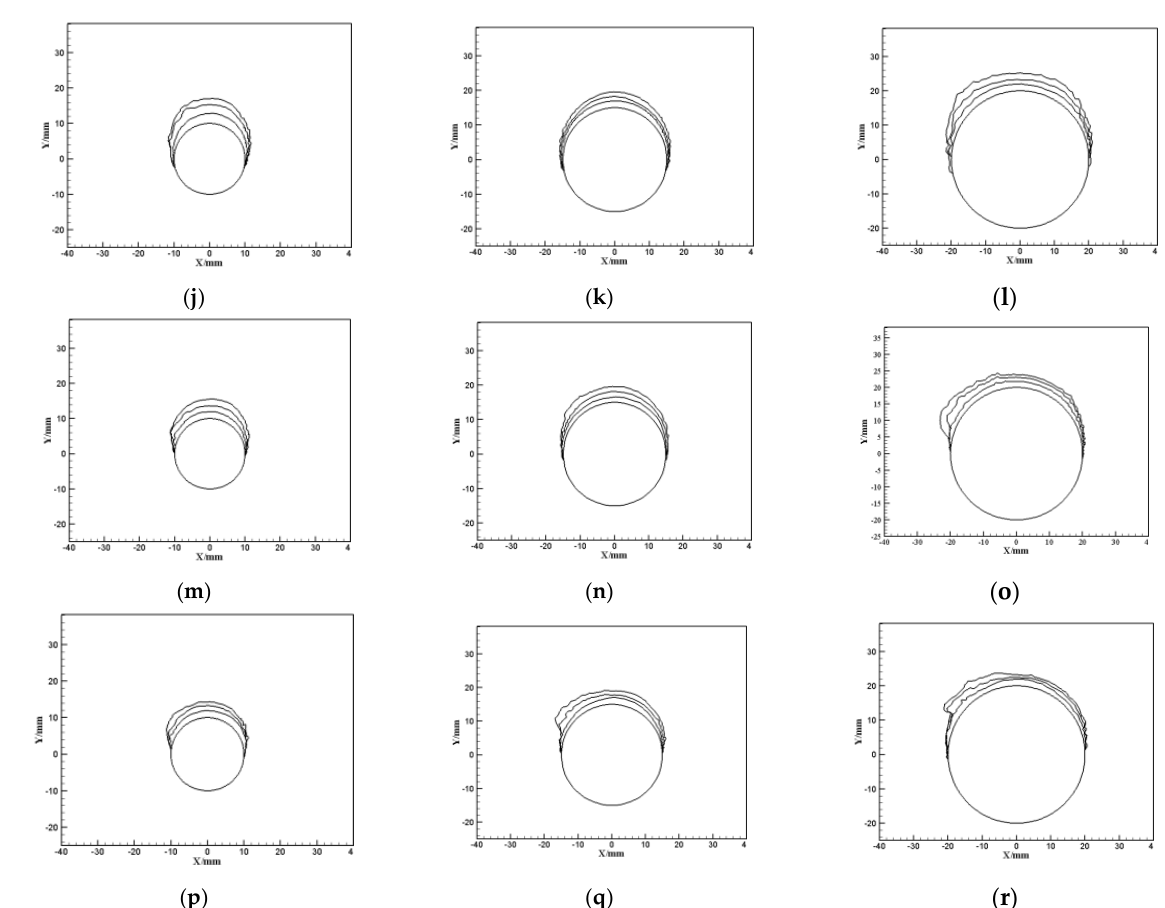
Figure 6. Test results of icing on the rotating cylinder surface under different TSRs: ( a ) λ = 0.2, d = 20 mm; ( b ) λ = 0.2, d = 30 mm; ( c ) λ = 0.2, d = 40 mm; ( d ) λ = 0.6, d = 20 mm; ( e ) λ = 0.6, d = 30 mm; ( f ) λ = 0.6, d = 40 mm; ( g ) λ = 1.0, d = 20 mm; ( h ) λ = 1.0, d = 30 mm; ( i ) λ = 1.0, d = 40 mm; ( j ) λ = 1.5, d = 20 mm; ( k ) λ = 1.5, d = 30 mm; ( l ) λ = 1.5, d = 40 mm; ( m ) λ = 2.5, d = 20 mm; ( n ) λ = 2.5, d = 30 mm; ( o ) λ = 2.5, d = 40 mm; ( p ) λ = 3.5, d = 20 mm; ( q ) λ = 3.5, d = 30 mm; ( r ) λ = 3.5, d = 40 mm.